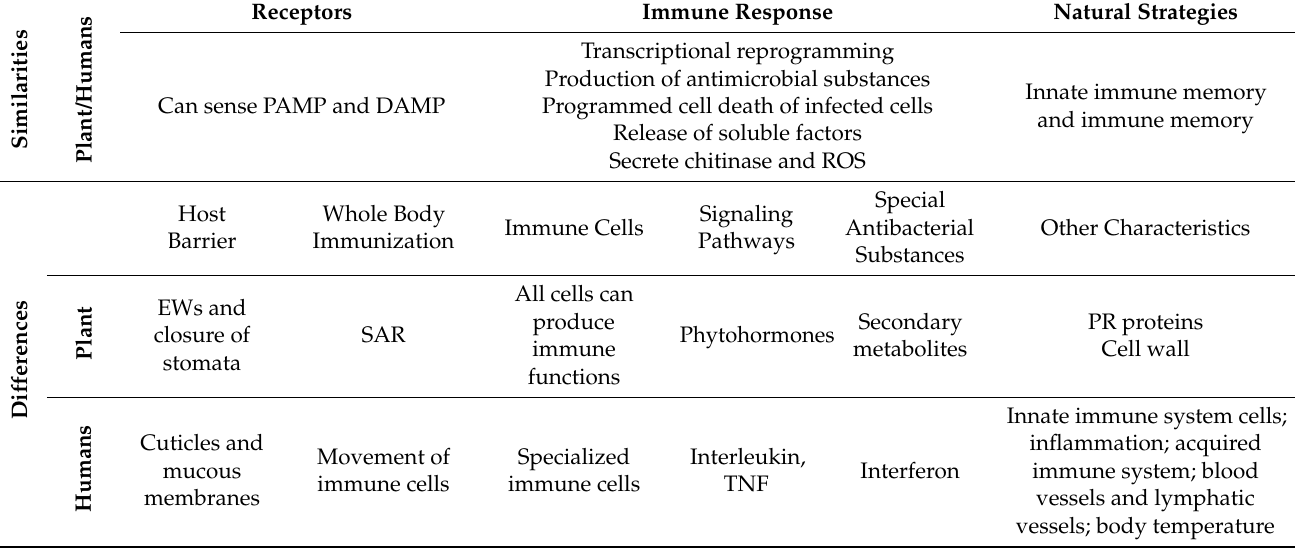
Table 1. Comparison between the pathogenic response in humans and